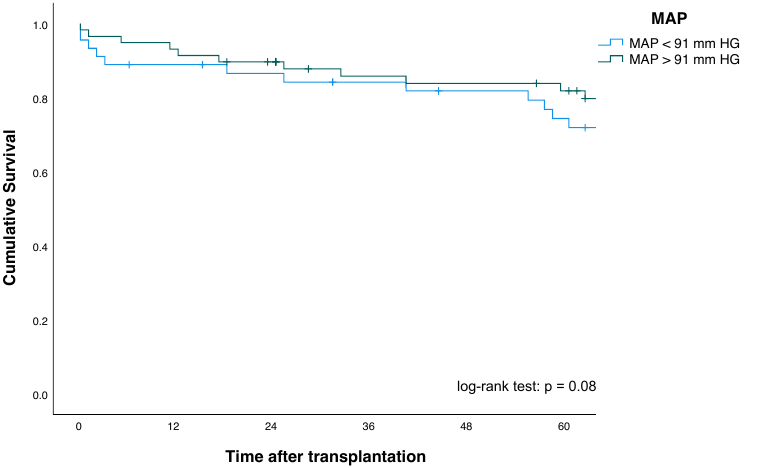
Figure 4. Kidney graft survival according to mean arterial pressure (MAP) after simultaneous pancreas–kidney